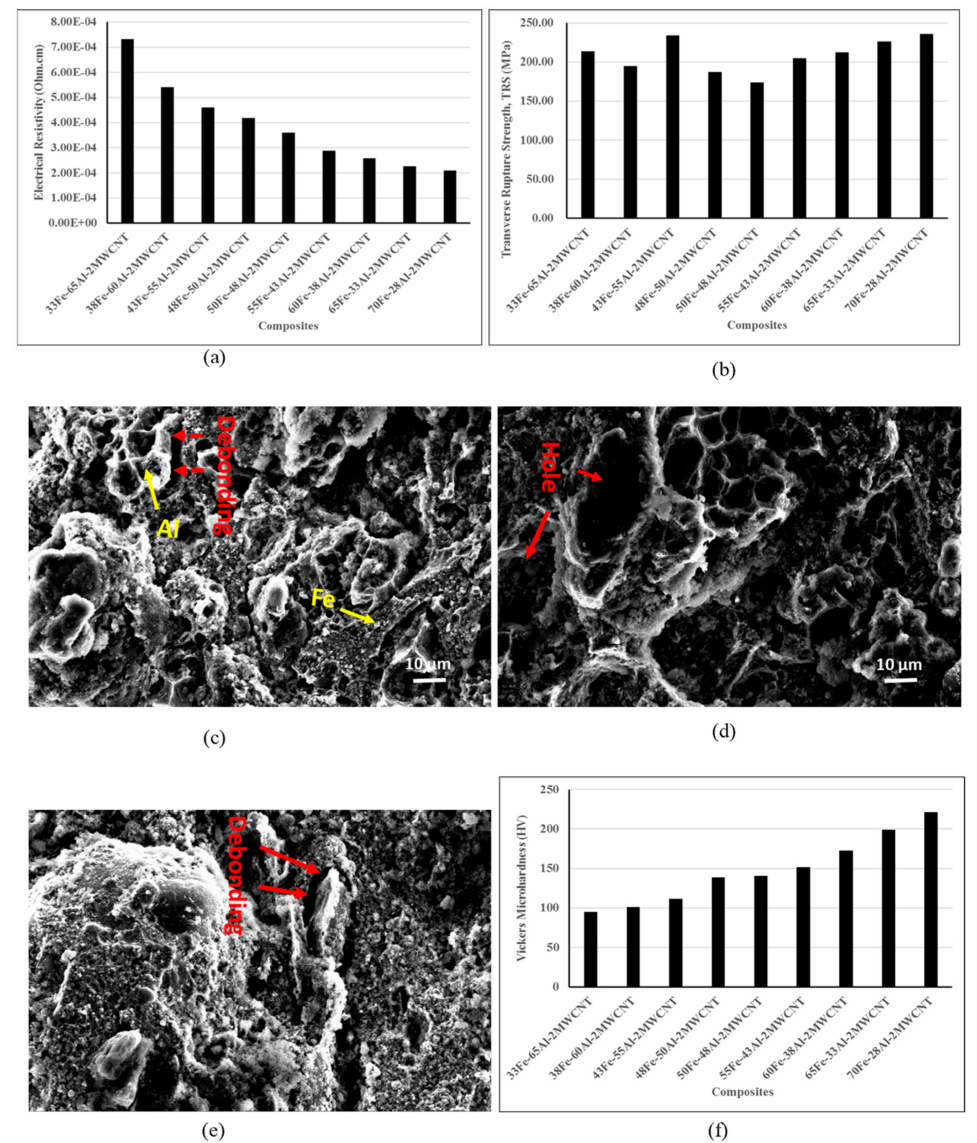
Figure 7. Electrical and mechanical properties of Fe-Al-MWCNT composites: ( a ) Electrical resistivity, ( b ) Mean transverse rupture strength (TRS); ( c ) Fractography SEM image of 33Fe-65Al- 2MWCNT; ( d ) Fractography SEM image of 50Fe-48Al-2MWCNT; ( e ) Fractography SEM image of 70Fe-28Al-2MWCNT; and ( f )